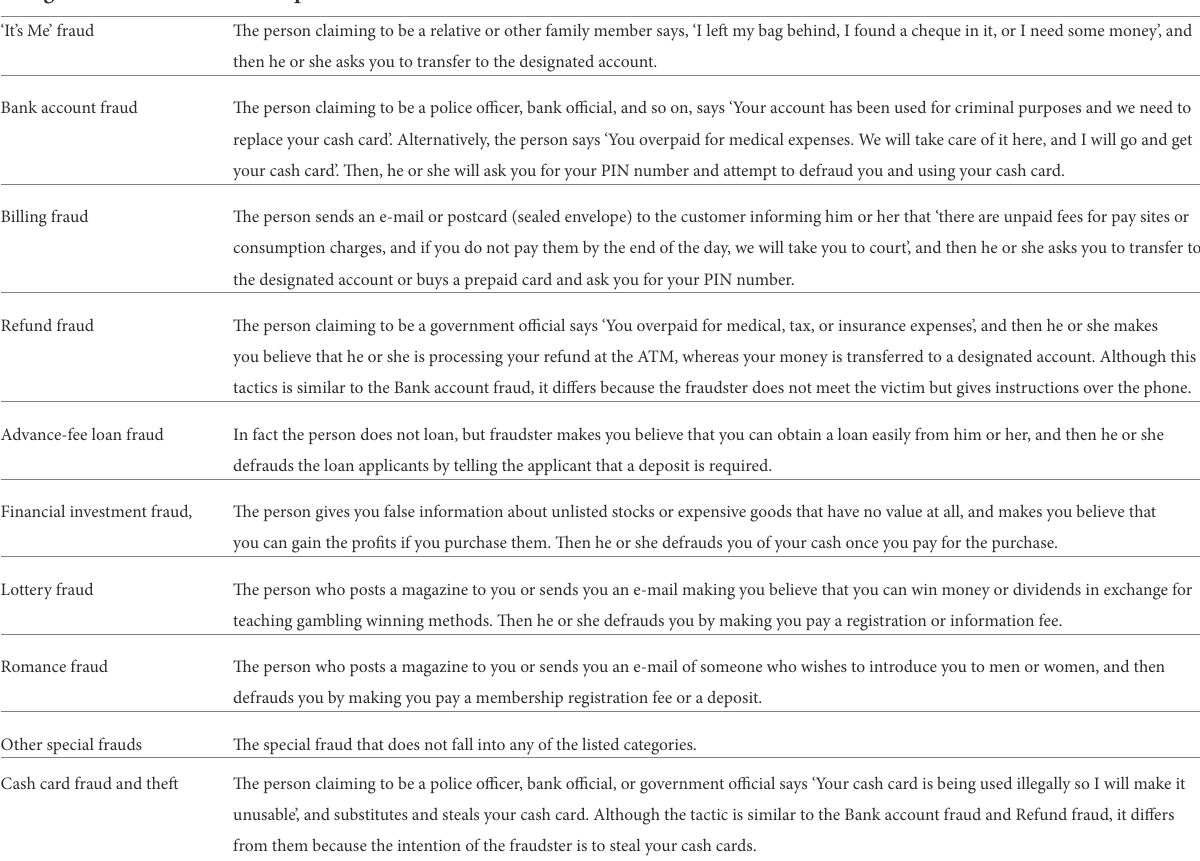
TABLE 1 Categories of Japanese fraud (special fraud)